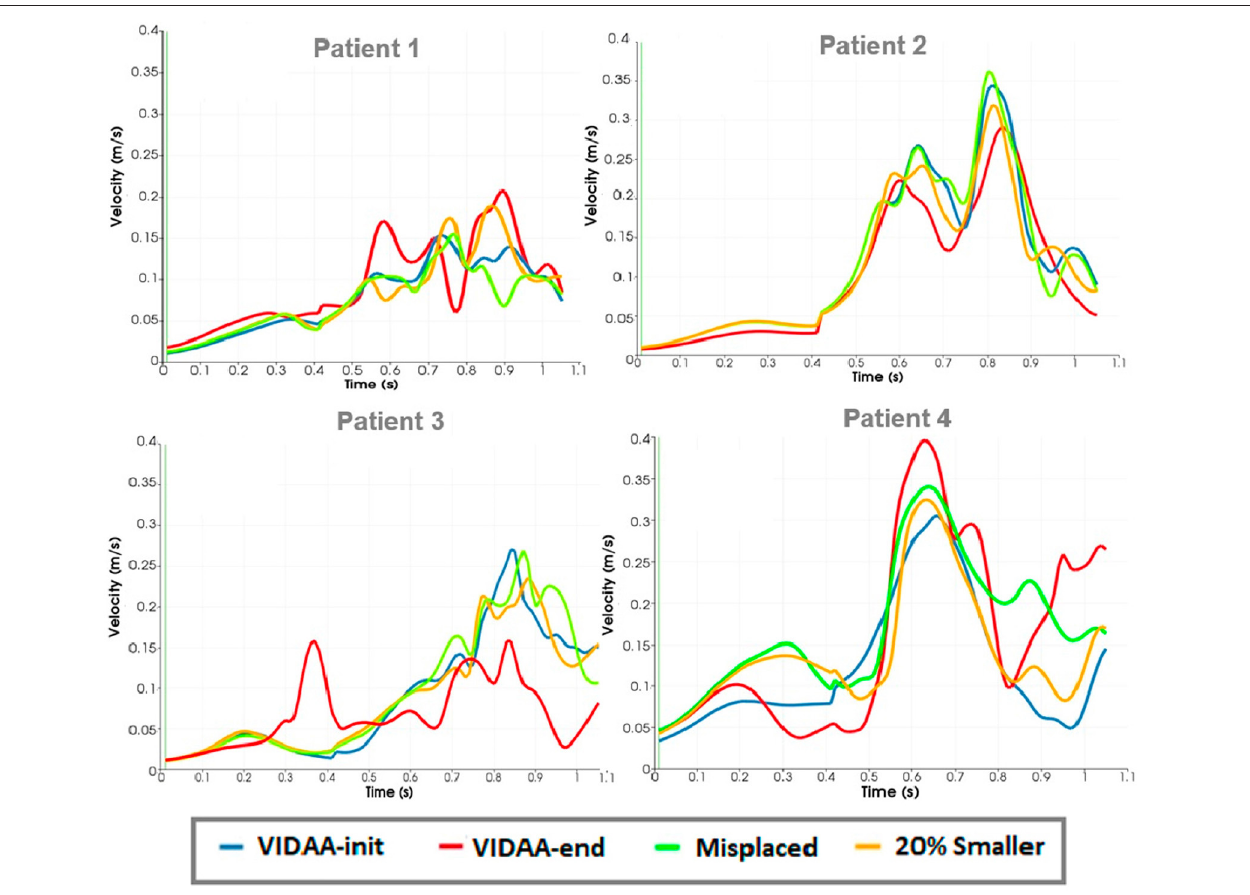
FIGURE 6 | Blood flow velocity curves over the whole cardiac cycle in a point outside the device in the left atrial cavity for all simulation scenarios in the four patients. VIDAA-init: device settings from morphological analysis and clinical recommendations; VIDAA-end: device settings after interactive manipulation in VIDAA; 20% smaller: device with a 20% smaller size than VIDAA-init; Misplaced: device with sub-optimal position and